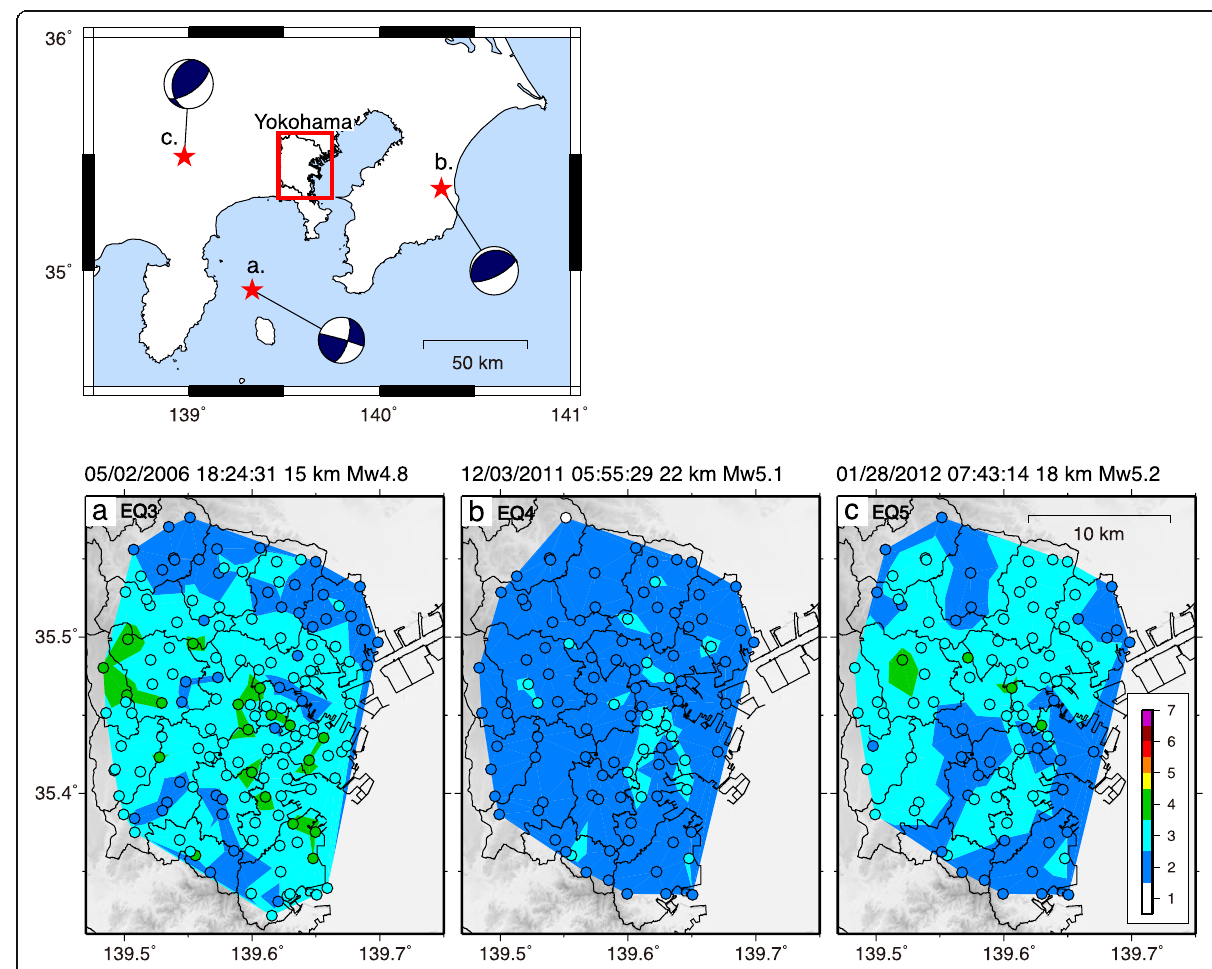
Fig. 11 Variation of I JMA s calculated at YCSMN stations for three shallow local events (hypocentral distance R ~ 60 to 70 km) with a moment magnitude (Mw) from 4.8 to 5.2 (see the list of earthquakes in Table 3 in Appendix). The incident azimuths of seismic waves are roughly from a south for EQ3; b east for EQ4; c west for EQ5. Note the variation of intensities observed at stations in YCSMN among the events even though